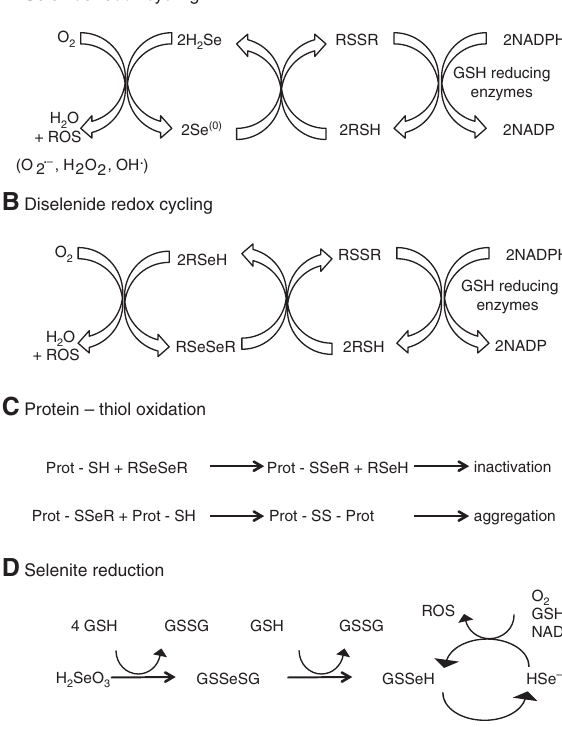
Figure 2: Redox reactions of selenium